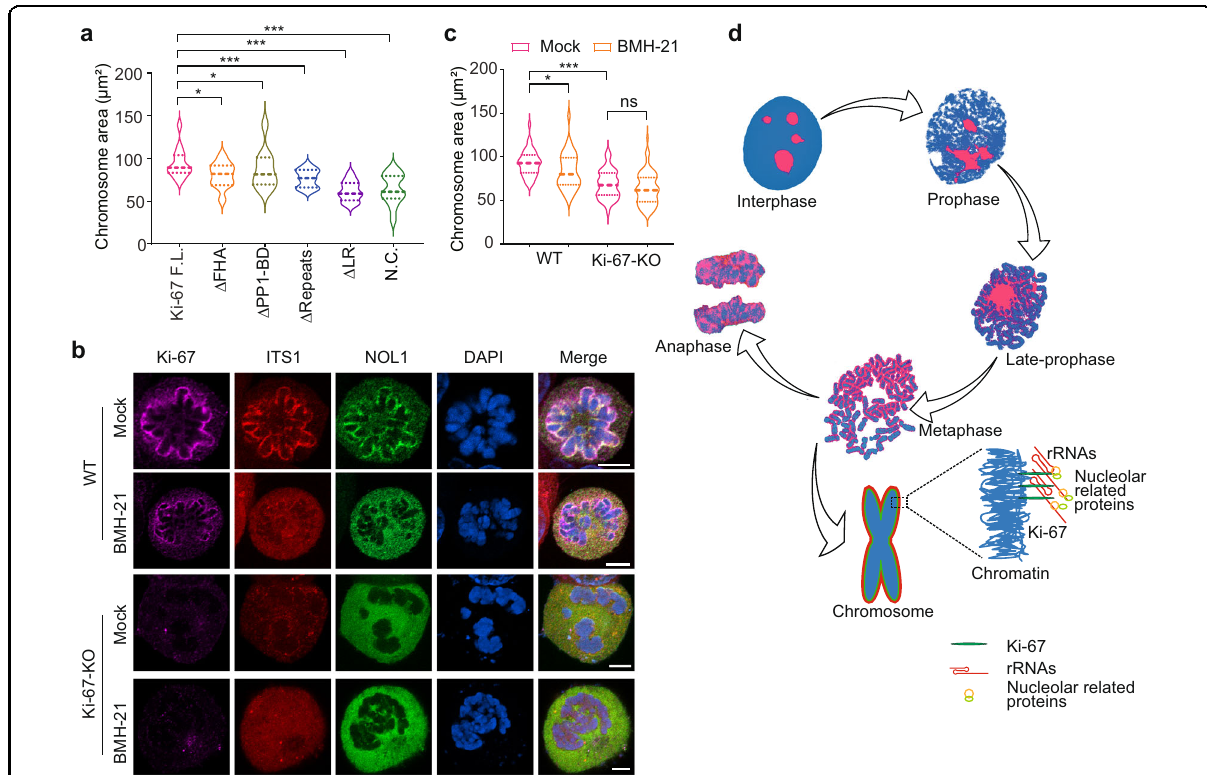
Fig. 6 Pre-rRNA facilitates chromosome dispersion at prometaphase. a Ki-67 promotes chromosome dispersion. Chromosome areas at prometaphase were measured in the cells expressing full-length Ki-67 or indicated Ki-67 mutants. b RNA polymerase I inhibitor treatment suppresses chromosome dispersion. Parental 293T cells or Ki-67-de fi cient cells were treated with BMH-21. The localization of Ki-67, pre-rRNA, and NOL1 was examined. Scale bar, 5 μ m. c Chromosome areas were analyzed by ImageJ. * P < 0.05; ** P < 0.01; *** P < 0.001. d A schematic model shows that pre- rRNAs gradually translocated from nucleoli to the periphery of chromosomes during mitosis. Ki-67 anchors these rRNA species on the condensed